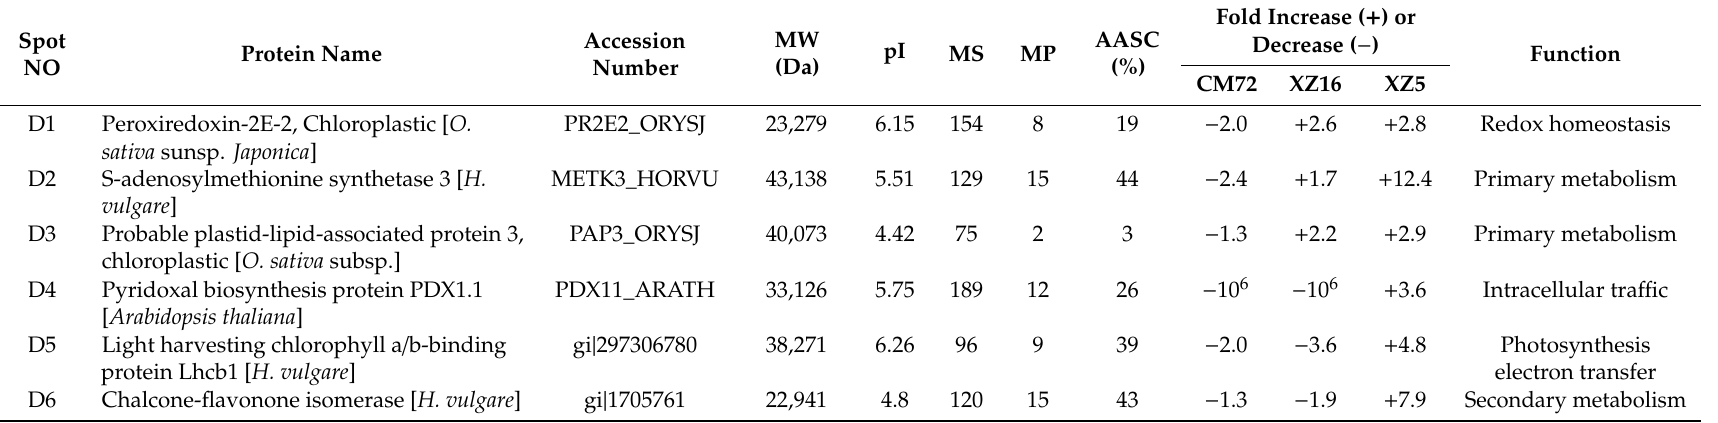
MS, Mascot score; MP, Matched peptide; AASC, Amino acid sequence coverage. Fold increase ( + ) or decrease ( − ) was calculated by drought vs. control. Protein spot ID refers to numbers in Figure 1D. Accession number of top database match from the NCBInr database. Fold increase and decrease were calculated as drought / control, and control / drought for up and downregulated proteins, respectively. All ratios shown are statistically significant ( p < 0.05). + 10 6 and − 10 6 referred to the specific expressed and totally inhibited proteins,